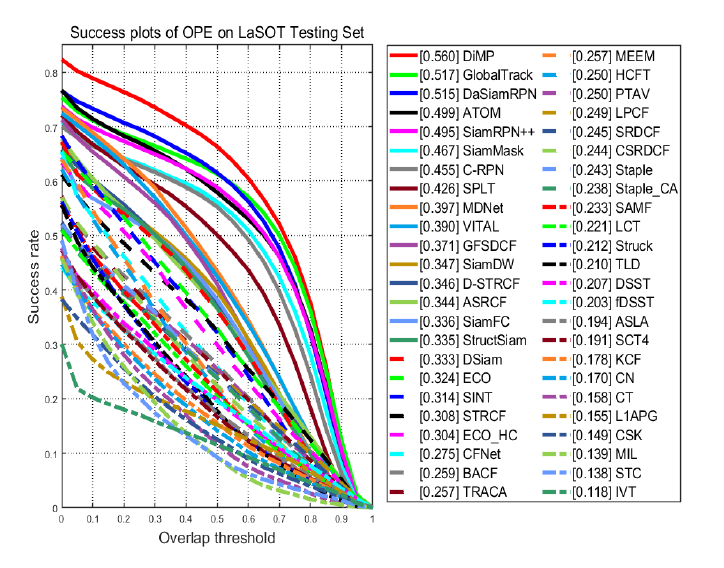
Figure 6. The success plots of OPE on LASOT. The numbers in the legend indicate the AUC scores. Our approach LPCF achieves 24.9% in terms of AUC score.